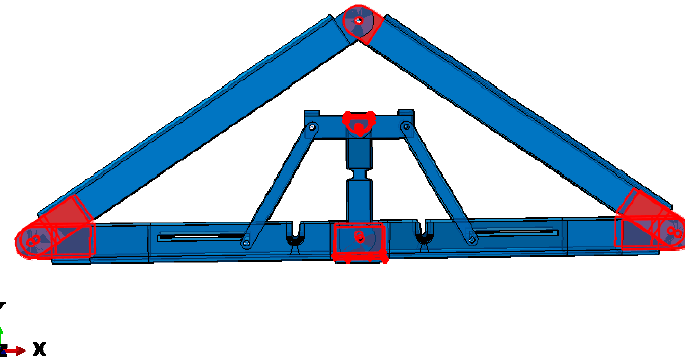
Figure 24. Contact surface interaction locations.